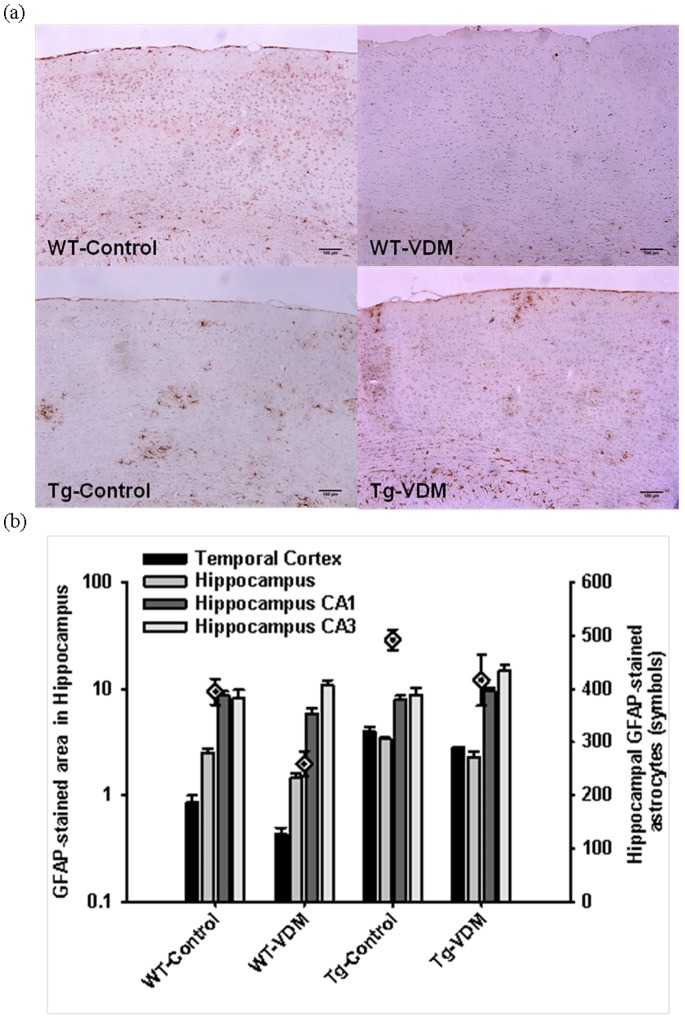
Immuno-histochemical quantification of GFAP-stained brain areas at 9 months.Typical images of GFAP-stained brains comparing mouse study groups (a), and results of quantitation by image analysis for the temporal cortex, total hippocampus, hippocampus regions CA1 and CA3 and hippocampal GFAP-stained astrocytes (symbols) (b). Two way ANOVA analysis indicated the following significant effects: genotype in the temporal cortex (P<0.001); both genotype and feed in the hippocampus (P<0.05); no effects in the CA1 hippocampus; feed (P<0.05) in the CA3 hippocampus; both genotype (P<0.05) and feed (P<0.05) for GFAP-stained astrocytes in the hippocampus. There were no significant interactions for any parameters.